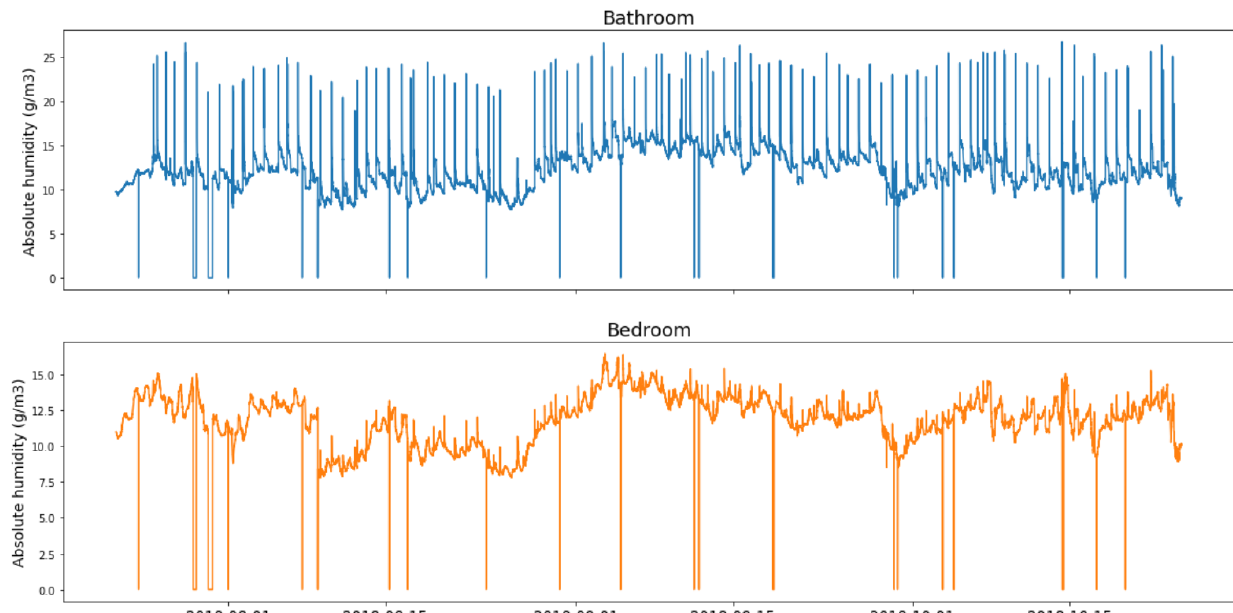
Figure 1. Absolute humidity in the evaluation dataset, shown for the bathroom ( top ) and bedroom ( bottom